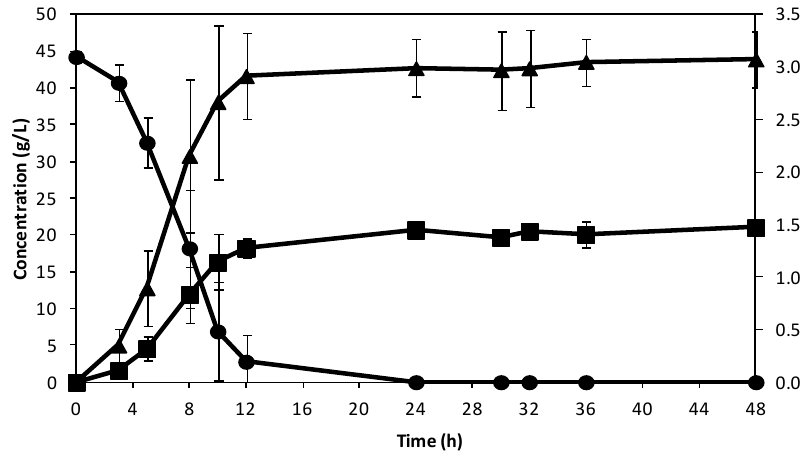
Figure 2. Concentration of sucrose (●) and ethanol (■) on the primary axis, and glycerol (▲) on the secondary axis with time, at 30 °C and with mixing.